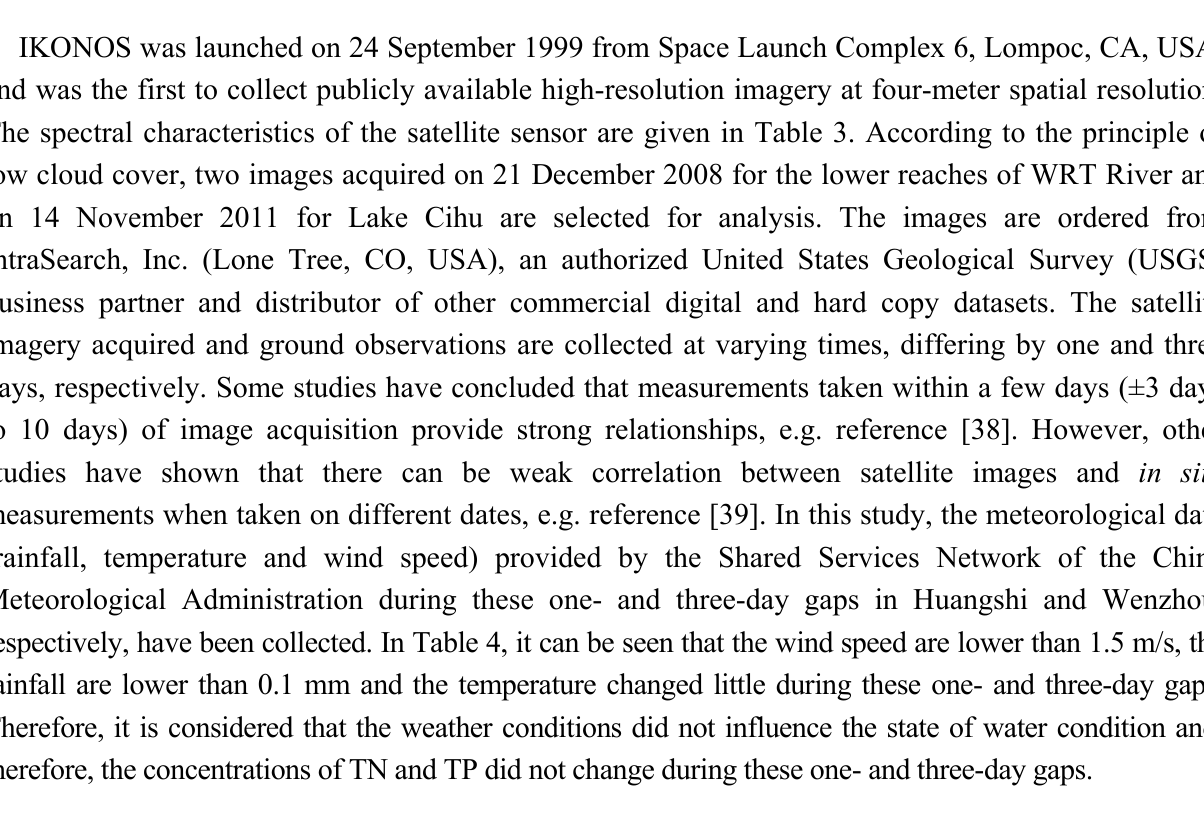
Table 3. Comparison of spectral characteristics of the four IKONOS bands used in this study and the first four Landsat/TM bands.